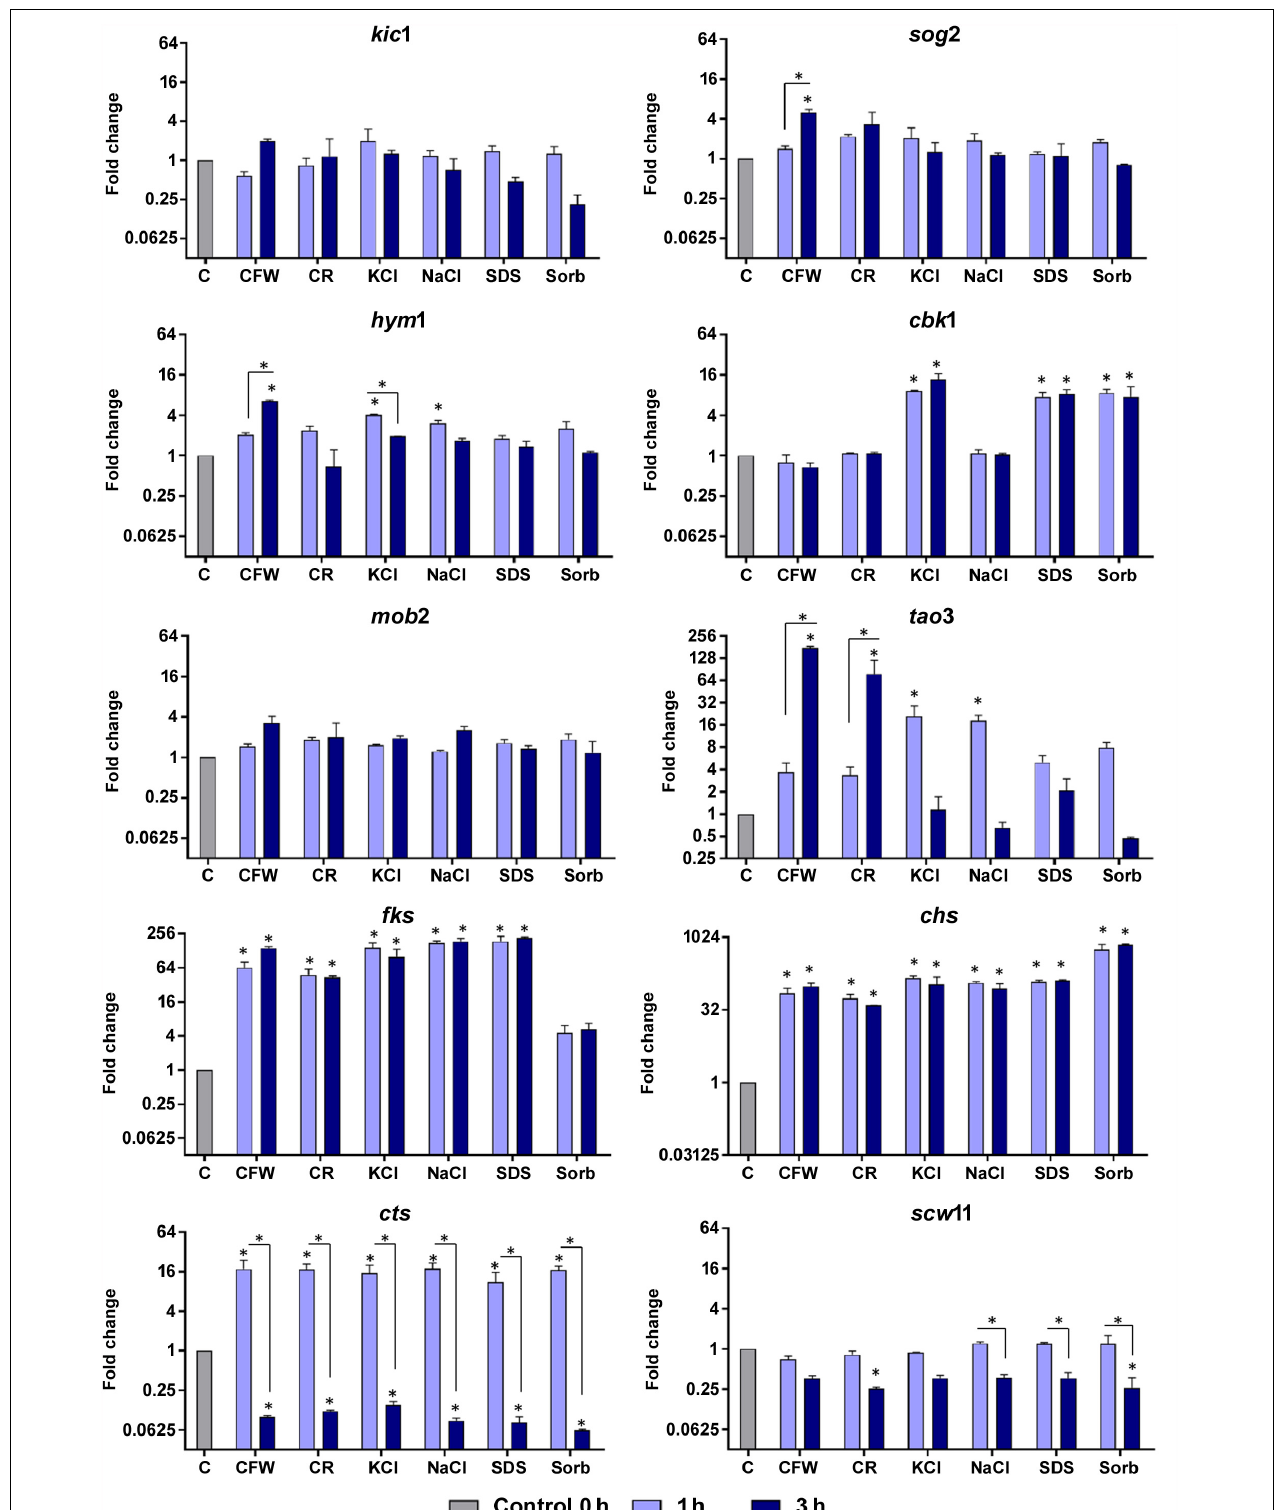
FIGURE 4 | Relative expression levels of genes encoding components of the RAM network or putatively regulated by Ace2 after exposure of T. rubrum to Calcofluor White (CFW), Congo Red (CR), KCl, NaCl, SDS, and sorbitol (Sorb), for 1 or 3 h. Control (C) is the growth of T. rubrum for 96 h before addition of the stressors. Data are means and SD of three independent experiments. Asterisks indicate statistical significance determined by ANOVA followed by Tukey’s ad hoc test ( P < 0.05).